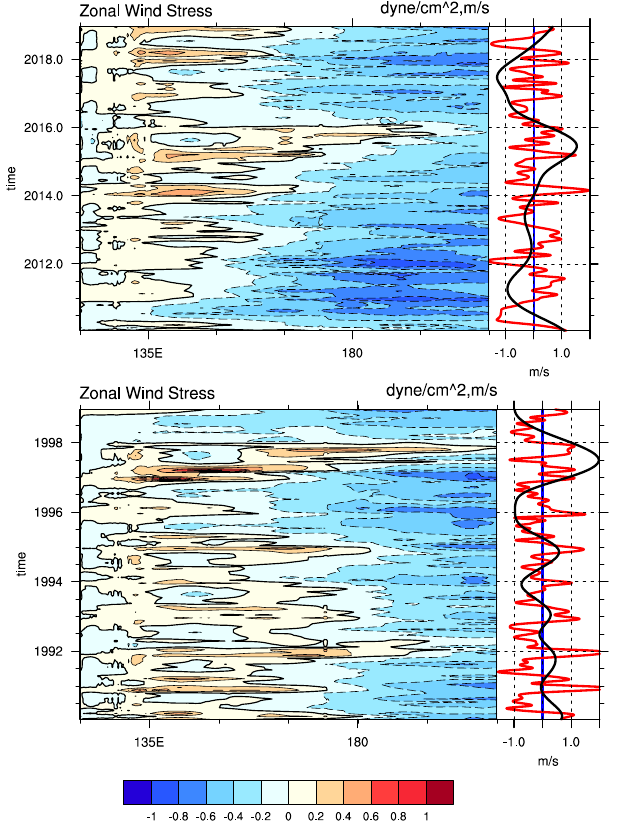
Figure 1. Time-longitude contour plots of the monthly zonal wind stress averaged for 2°S–2°N (left panel; in dyne/cm 2 ) interpolated to daily data over two decades covering two extreme ENSO events. The top panel is the 2015/16 case, and the bottom panel is the 1997/98 case. Blue shading represents negative wind stresses, while orange shading represents positive wind stress. The solid contours are positive values and represent westerly winds, and the dashed contours are easterly winds. Right panels are IMFs 6–8 in red and IMFs 9–10 in black curves (units: m/s). Note that the red curves follow each orange peak of the zonal wind stress on the right panel, and the black curves, representing ENSO-related winds, follow the zero lines of the surface zonal wind stress. The black curves indicate the interannual variability, with peaks that follow the ENSO events, and the red curves fluctuate with seasonal variability. Maps were generated using the NCAR Command Language (NCL; https :// www.ncl.ucar.edu/), version